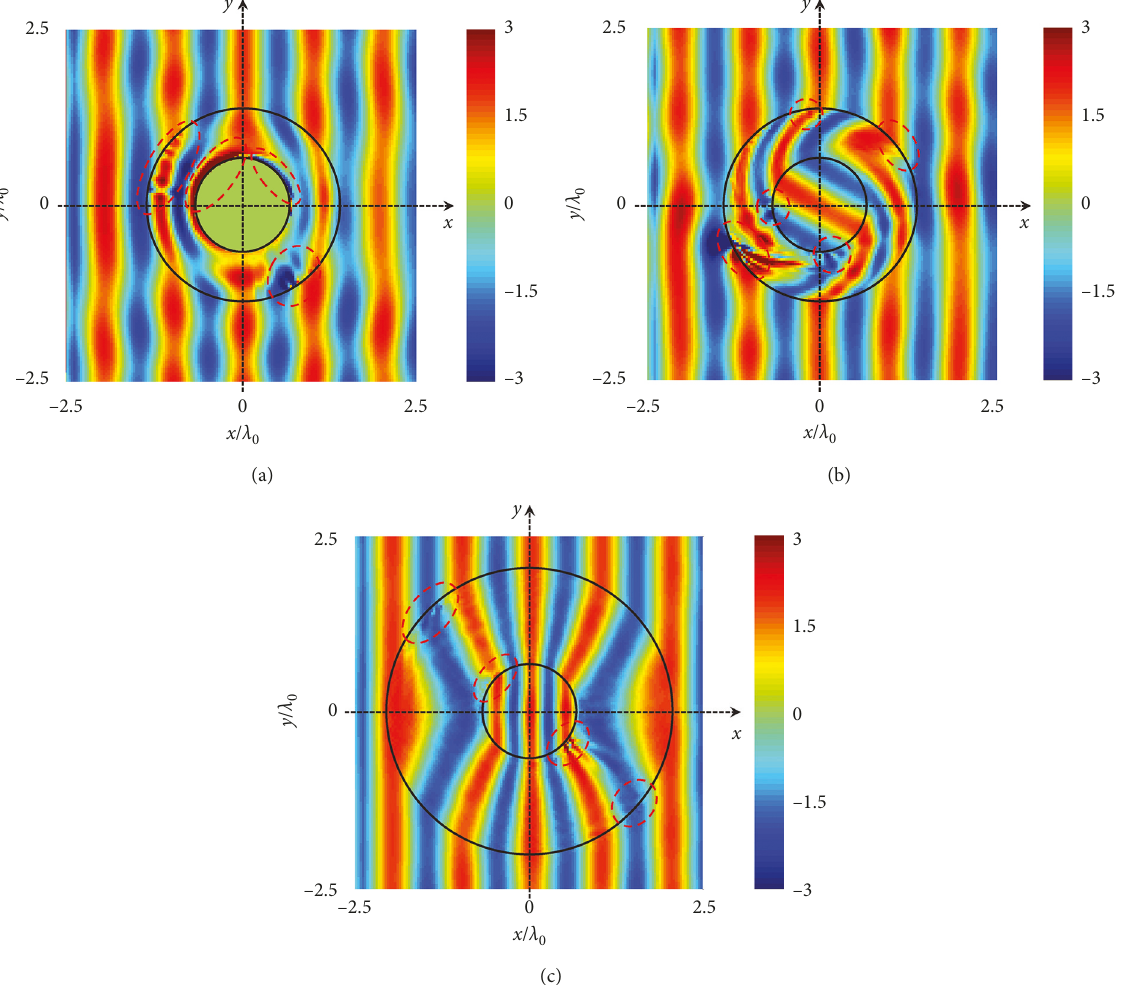
Figure 9: FDTD snapshots with the use of linear functions: (a) the cloak, (b) the rotator, and (c) the concentrator. The red dotted circles indicate the location of stair-casing